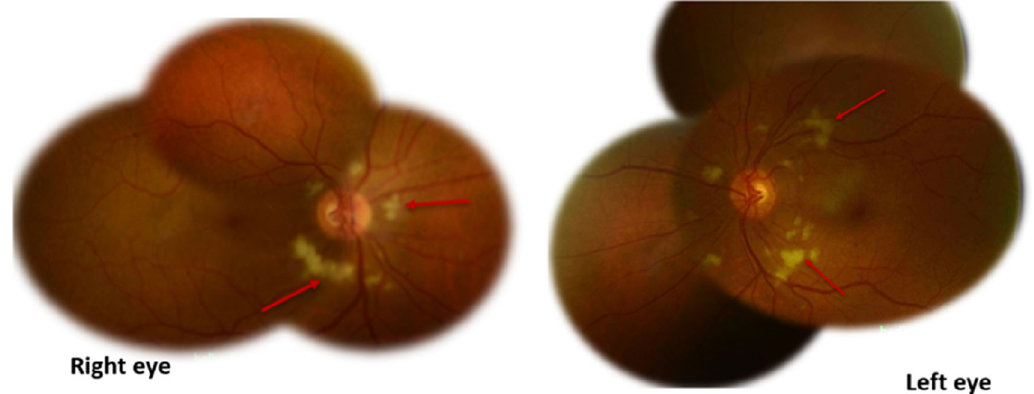
Figure2.Compositefundusphotographsshowedmultipleareasofretinalwhiteningintheperipapillaryarea (red arrows).